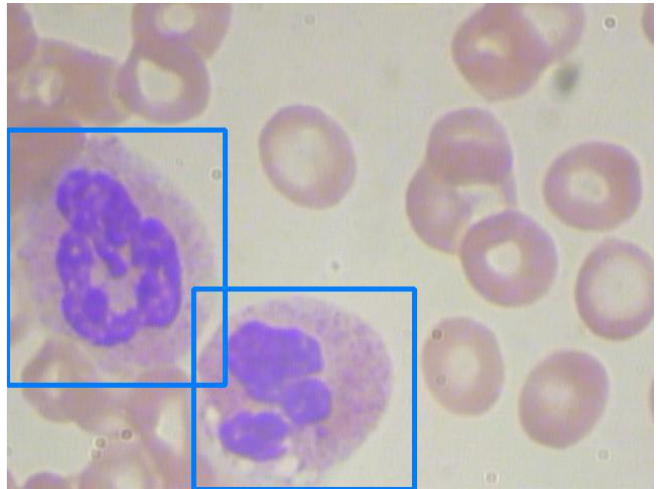
Figure 9. An image with adjacent white blood cells. Table 7. Comparison of the experiment results between Figure 9 and validation set. Confidence Score: 0.9